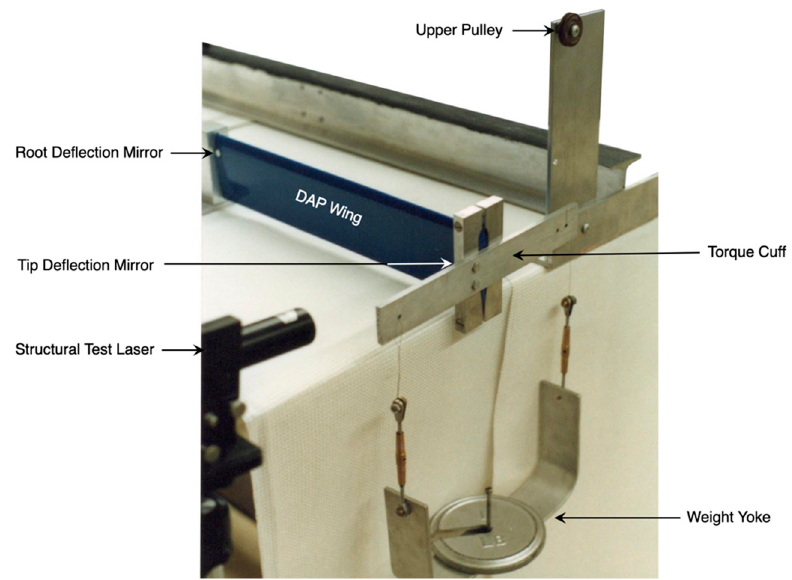
Figure 9. Wing torsional stiffness test rig.